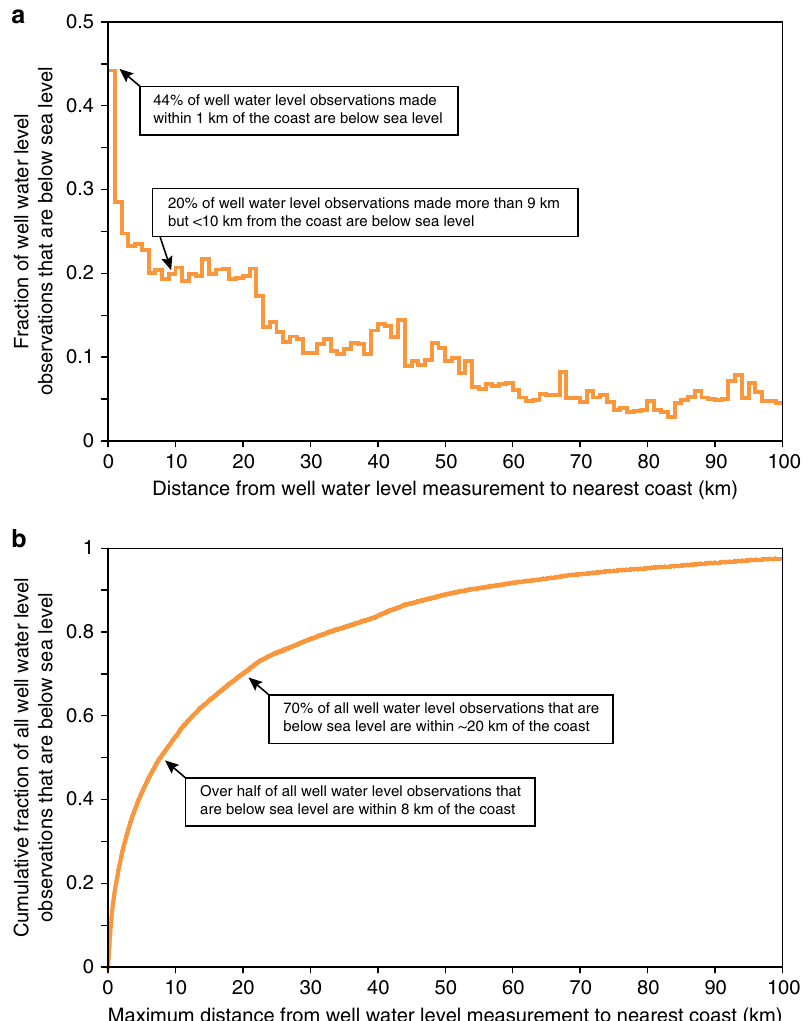
Fig. 3 Fraction of well water elevations that are below sea level, as a function of distance from the coastline. a Fraction of well water elevations below sea level, as a proportion of all recorded well levels at varying distances to the nearest coast. b Cumulative fraction of all well water elevations that are below sea level. More than half of all wells with water elevations that lie below sea level are within 10 km of the coast. Each well is counted only once; for wells with multiple measurements postdating 2000, we calculated median well water elevations for 2000 – present and incorporate only this median value in our calculations to produce the above fi